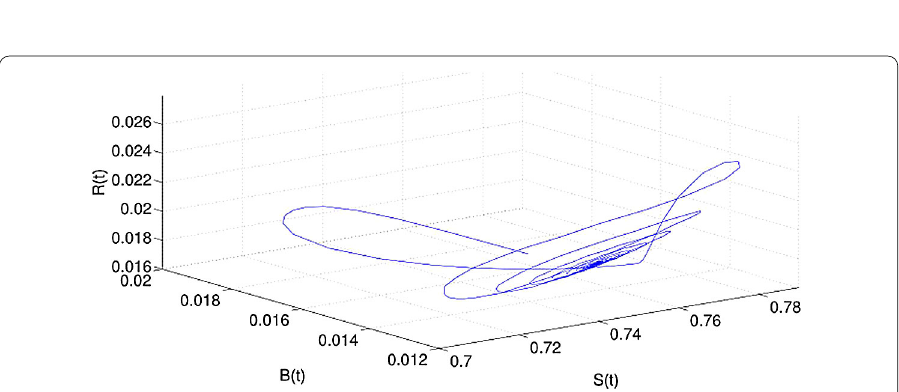
Figure 2 Dynamic behavior of system (41): projection on S-B-R with τ 1 = 4.5342